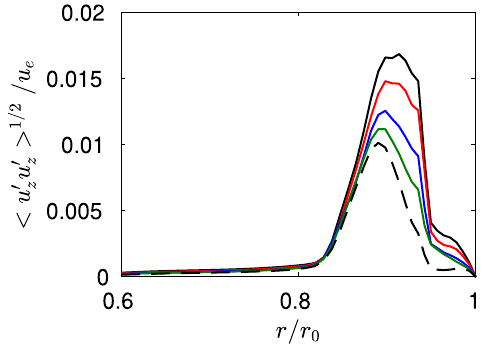
Figure 1. Nozzle-exit pro fi les of axial turbulence intensity h u 0 u 0 i 1 = 2 = u L = 15 r L = 20 r L = 25 r e for z 0 , 0 , 0 , z L = 30 r 0 , and for the free jet